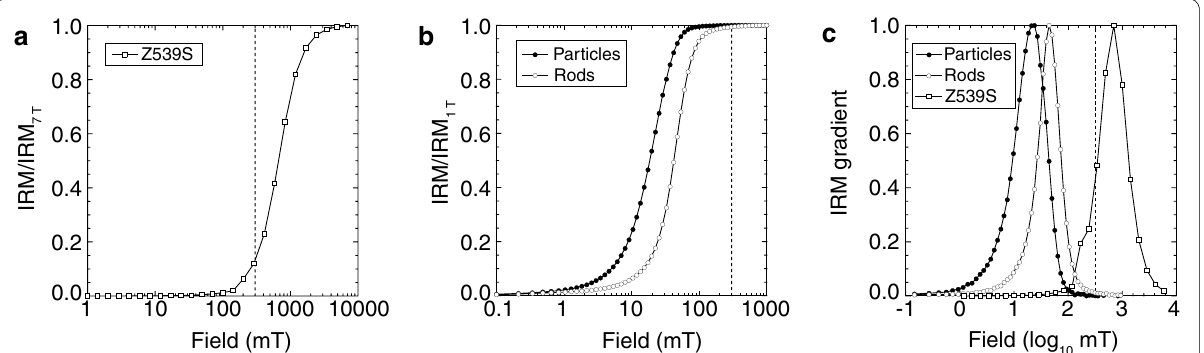
Fig. 1 Illustration of IRM acquisition in a hematite and b magnetite. The small IRM acquisition below 300 mT in a and complete acquisition of SIRM below 300 mT in b explains the basis for use of a 300‑mT cut‑off field to discriminate between low‑coercivity magnetite and high‑coercivity hematite. The sample in a is red pigmentary Zebra rock sample Z539S (Abrajevitch et al. 2018) and the samples in b are synthetic nanoparticulate magnetites (“particles” are equidimensional magnetite (40–85 nm diameter); rods are elongated with length 250–300 nm and width 60–110 nm), which were synthesized following Hu et al. (2011). c First derivative curves of the IRM (i.e., gradient) for the three samples illustrated in a , b , which provide a measure of the respective coercivity distributions in relation to the 300 mT cut‑off field. Dashed vertical lines represent the 300‑mT cut‑off